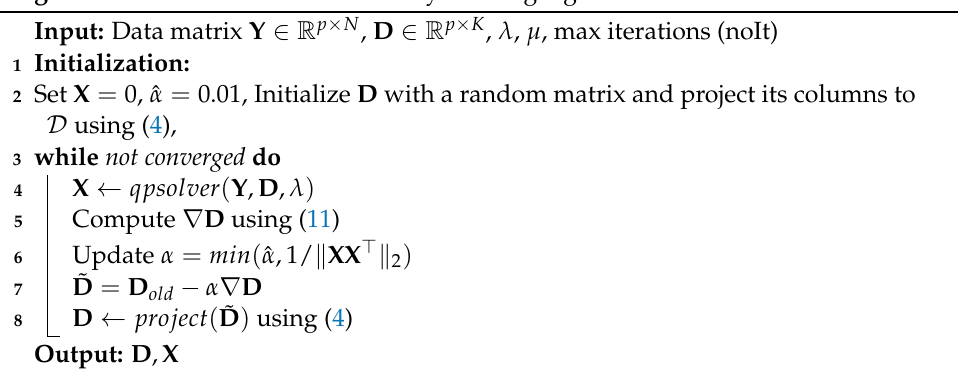
Algorithm 1: A1: Incoherent dictionary learning